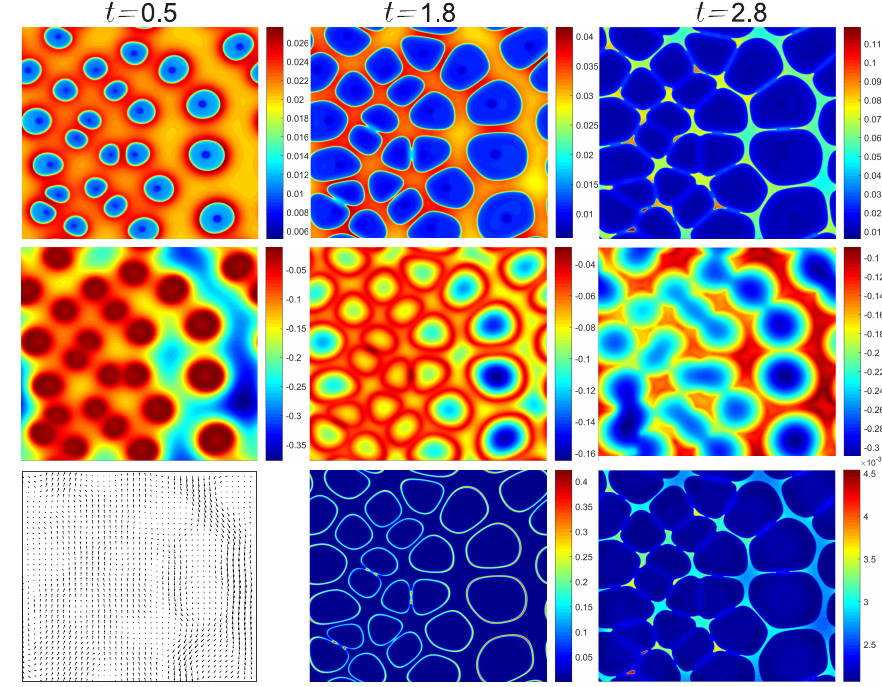
Figure 5. Transient results of solute volume fraction (1st row), temperature (2nd row), and velocity vectors, volumetric flow rate, and liquid viscosity on the 3rd row at time instants (cid:101) t = 0.5,1.8, and 2.8, respectively. Initial conditions (cid:101) T = − 1.0 and φ c = 0.02 (about 3.1 wt %), and an assumed cooling rate with β f = 100